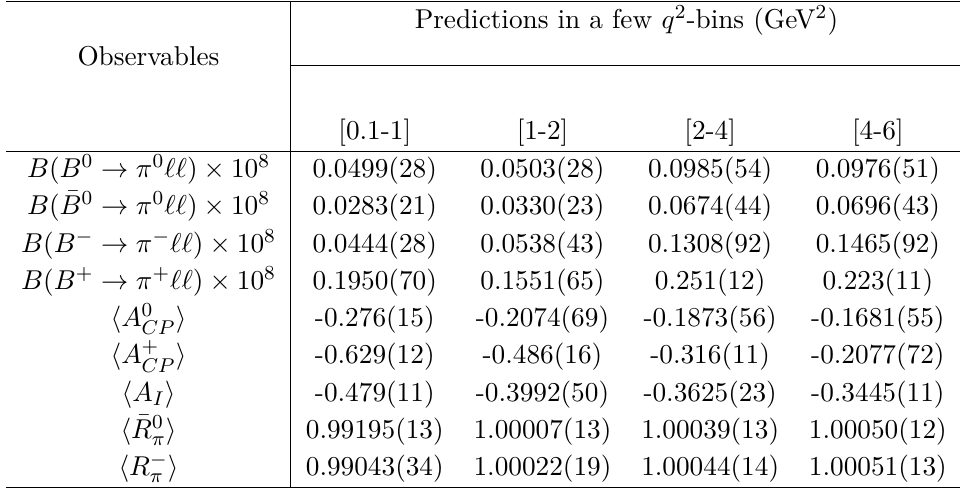
Table 6 . Predictions of observables for B → π‘‘ decays in the SM, obtained using the fit results given in table